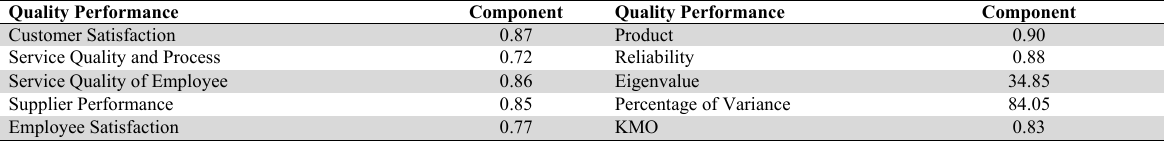
Factor Analysis on Quality Performance